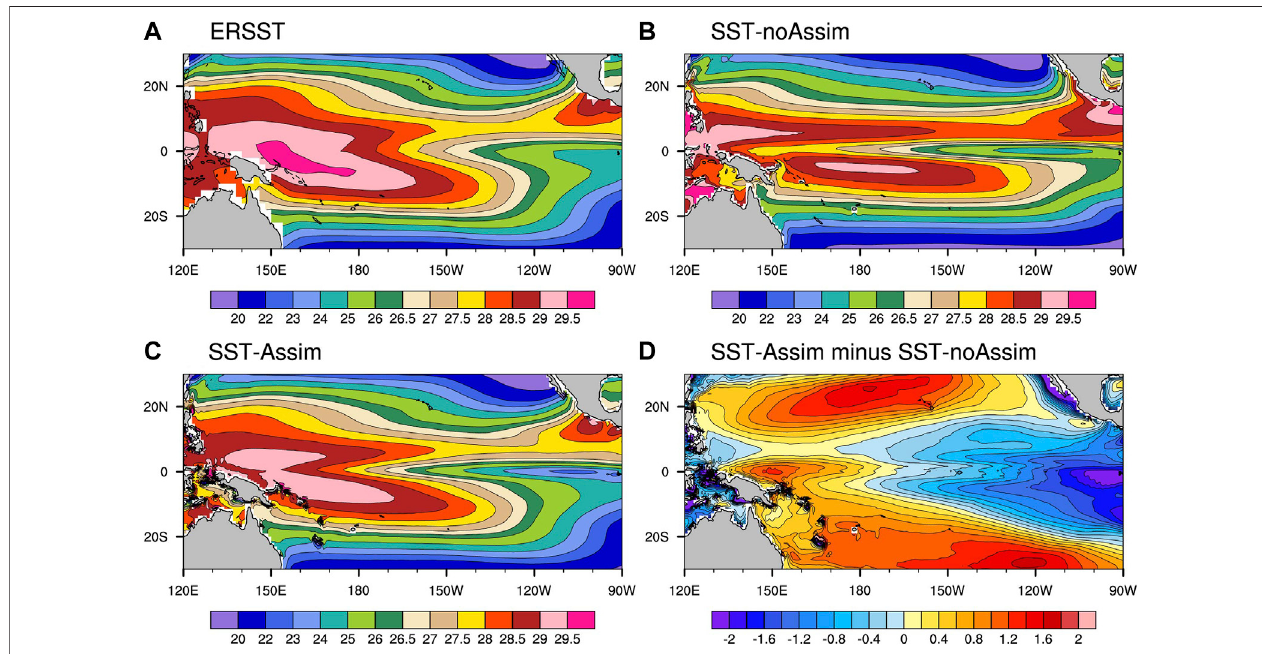
FIGURE 2 | Meridional – vertical sections of annual mean zonal currents (m/s) at (A) 180 ° E, (B) 140 ° W, and (C) 110 ° W for Johnson et al. (2002) climatology (D – F) and (G – I) arethesame as (A – C) butfortheSST-noAssim experiment andtheSST-Assim experiment, respectively.Thecontour intervalforallthepanelsis0.1 m/s.The eastward (westward) velocities are shown as solid (dashed) lines. The average period of the model data is from 1985 to 2000, and the positive values indicate an eastward direction.